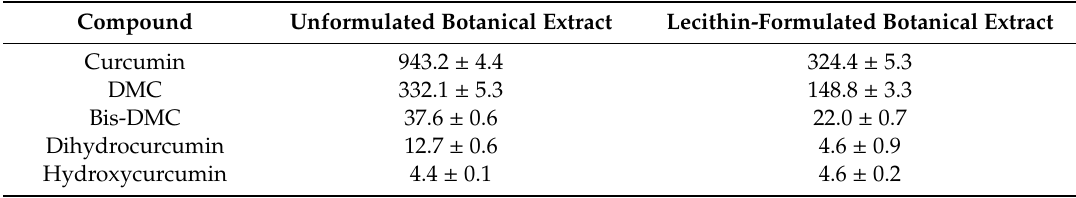
Table 1. Quantification of curcuminoids in curcumin-derived botanical extracts. Data are expressed as mg / g (mean values ± SD, n =